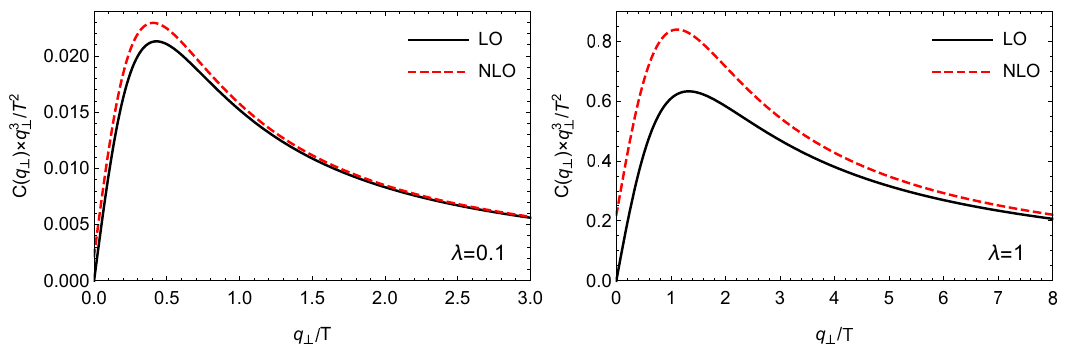
Figure 7 . C( q ⊥ ) q 3 ⊥ /T 2 as a function of q ⊥ /T for different values of the coupling. The solid × black lines come from eq. (4.10), while the dashed red ones from eq. (4.11). The area under the curves is directly proportional to ˆ q